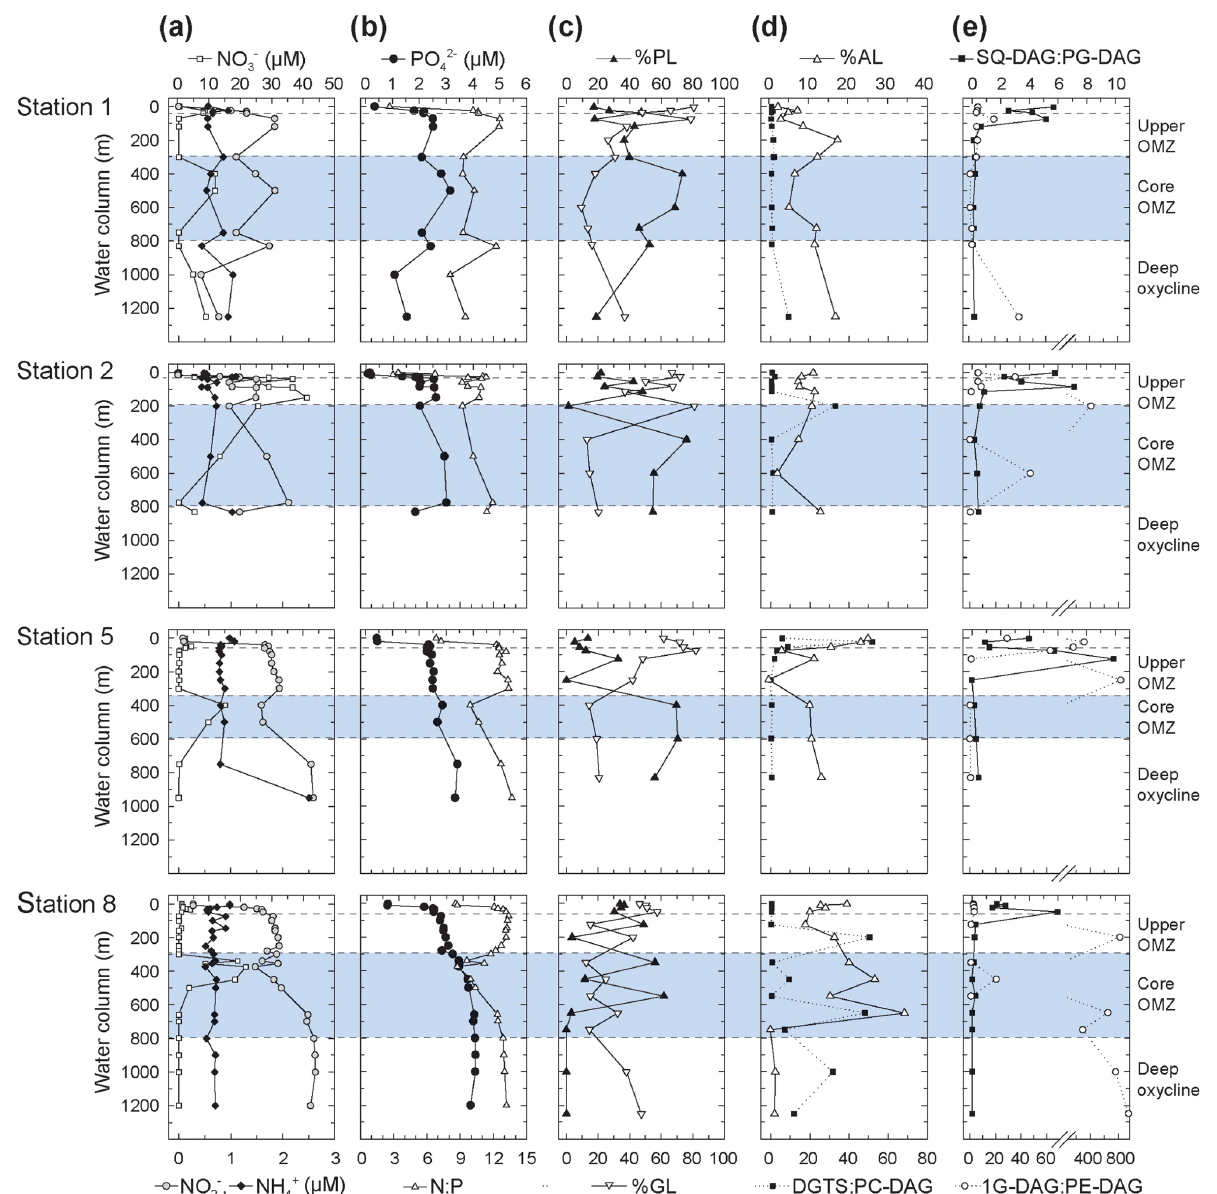
Figure 3. Depth profiles of (a) nitrate, nitrite, and ammonium; (b) phosphate and N : P; (c) total non-archaeal (non-isoprenoidal) phospho- lipids, glycolipids and (d) aminolipids shown as percent of total intact polar lipids and ratios of non-phospholipids to phospholipids for DGTS to PC-DAG; (e) SQ-DAG to PG-DAG; (e) and 1G-DAG to PE-DAG. Also depicted are the different geochemical zones in the water